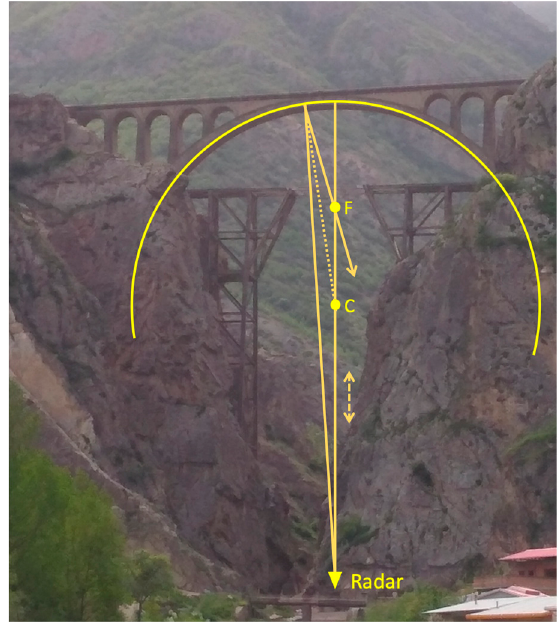
Figure 6. Geometry of the radar acquisition at Veresk Bridge.